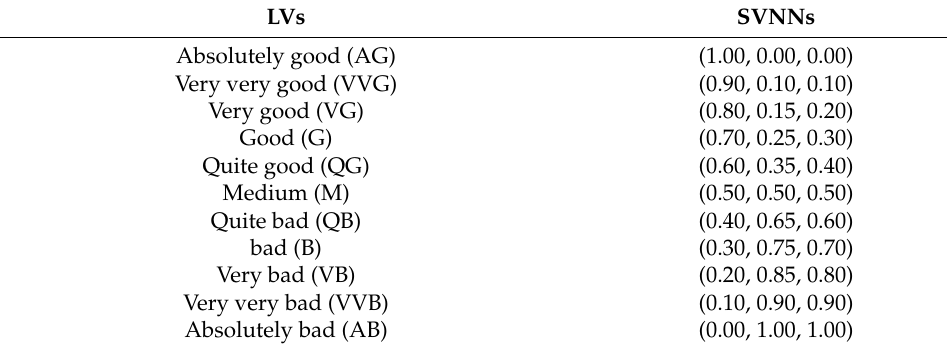
Table 4. Linguistic ratings of RESs over given criteria.